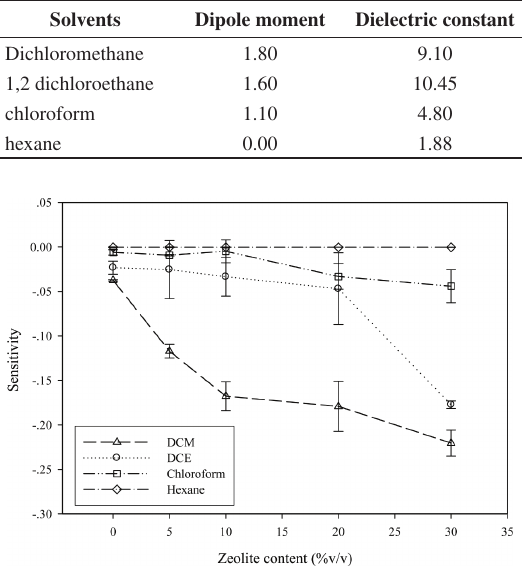
Figure 3. The sensitivity of D-PDPA/Y_H + [80] at various zeolite concentrations when exposed to halogenated solvents at 27±1°C and 1 atm.